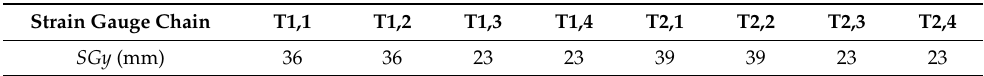
Table 2. Position of strain gauge chains. Distance SGy determines center of first strain gauge from end of